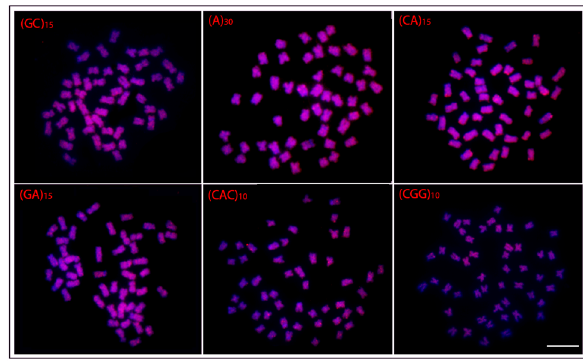
Figure 5 – Hybridization patterns with microsatellites probes (red signals) on metaphase plates of the Osteochilus microcephalus . Chromosomes were counterstained with DAPI (blue). Scale bar = 5 μm.